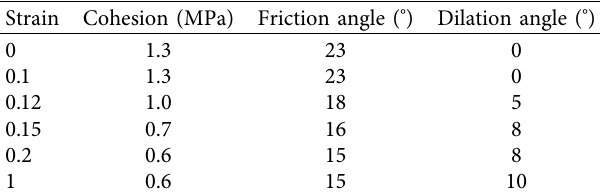
Table 5: Mechanical parameters of strain-softening model.